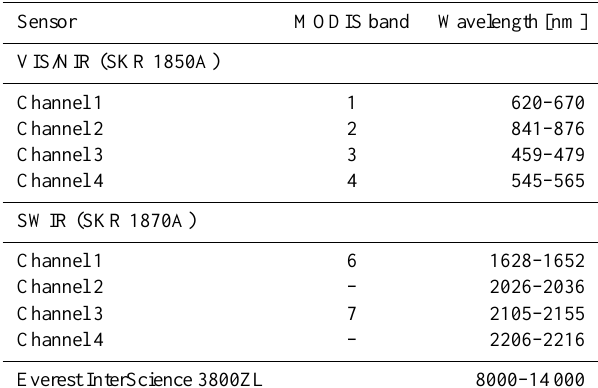
Table 1. Multispectral and thermal infrared instrument